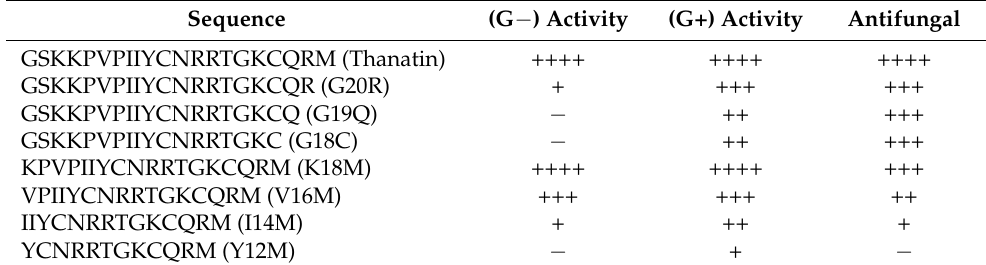
Table 2. Primary structures and antimicrobial activity of truncated variants of thanatin. G: Gram Sequence